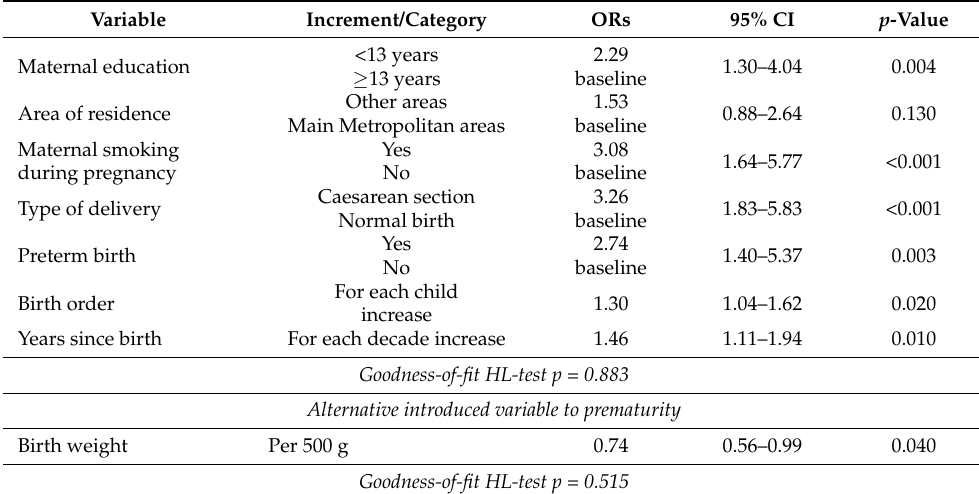
Table 2. Clustered multiple logistic-regression-derived Odds Ratios (ORs) and 95% Confidence intervals (95% CI) assessing the odds of not initiating breastfeeding with maternal sociodemographic and lifestyle characteristics and perinatal